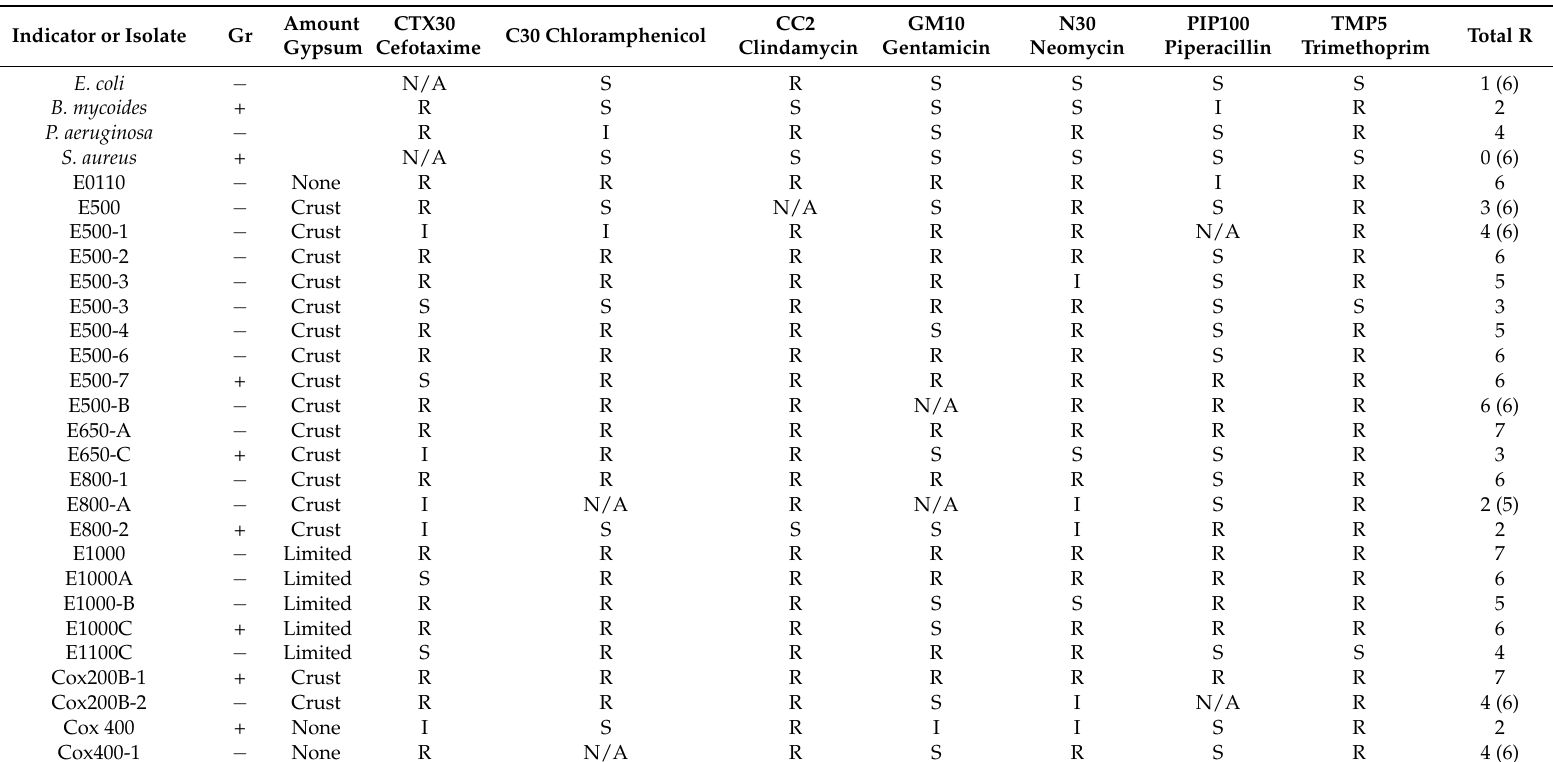
Table 3. Sensitivity of indicator bacteria and cave isolates to seven antibiotics. Isolates were designated according to sample location (E = Edwards, C = Cox; and distance in m from the entranced or the branch point of Cox from Edwards) and Gram stain (G + is Gram Positive, − is Gram negative), as S = sensitive, I = intermediate, or R = resistant. N/A, not available. Total R is the number that were resistant out of seven antibiotics tested unless otherwise noted in parentheses. Indicator or